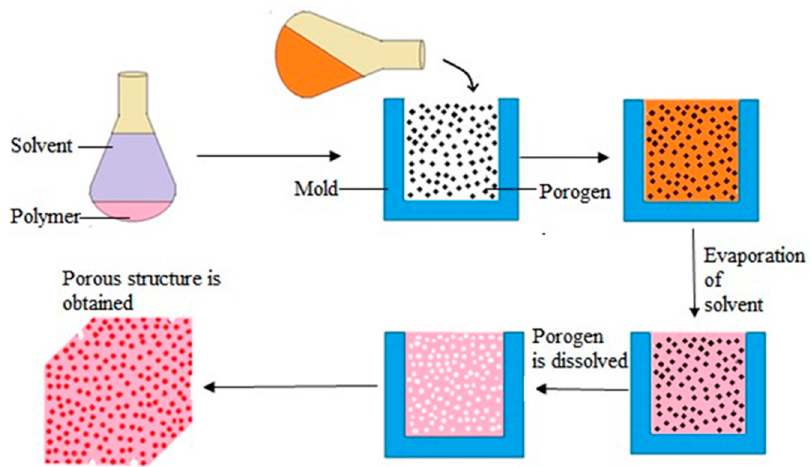
Figure 8. The schematic diagram of solvent casting and particulate leaching technique.